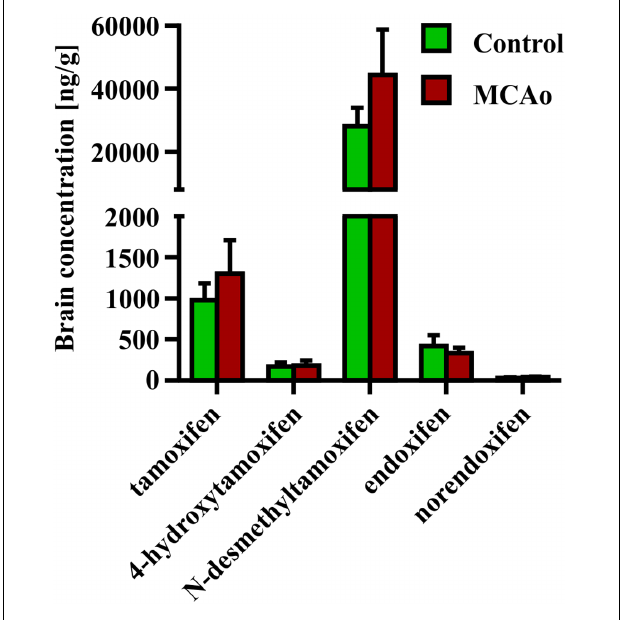
FIGURE 6 | Influence of blood-brain barrier disruption on brain concentration of tamoxifen and its metabolites. Disruption of the blood-brain barrier by the middle cerebral artery occlusion, causes no changes in the ipsilateral hemisphere concentration of any tamoxifen